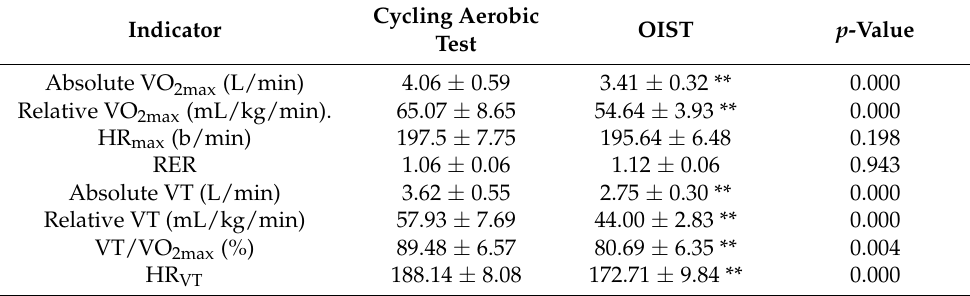
Table 8. Results from Cycling Aerobic Test and OIST ( n = 14). Indicator